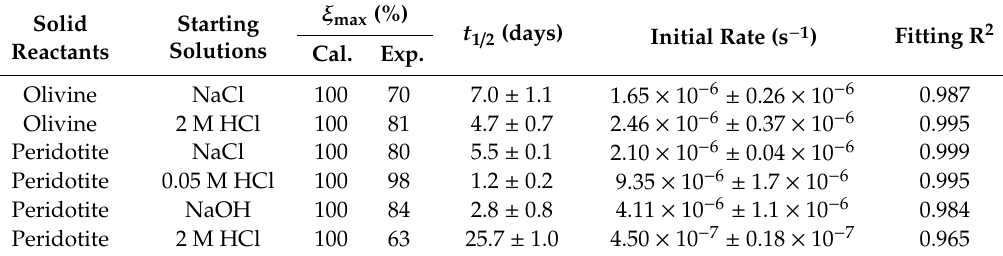
Table 2. Kinetic parameters for serpentinization of olivine and